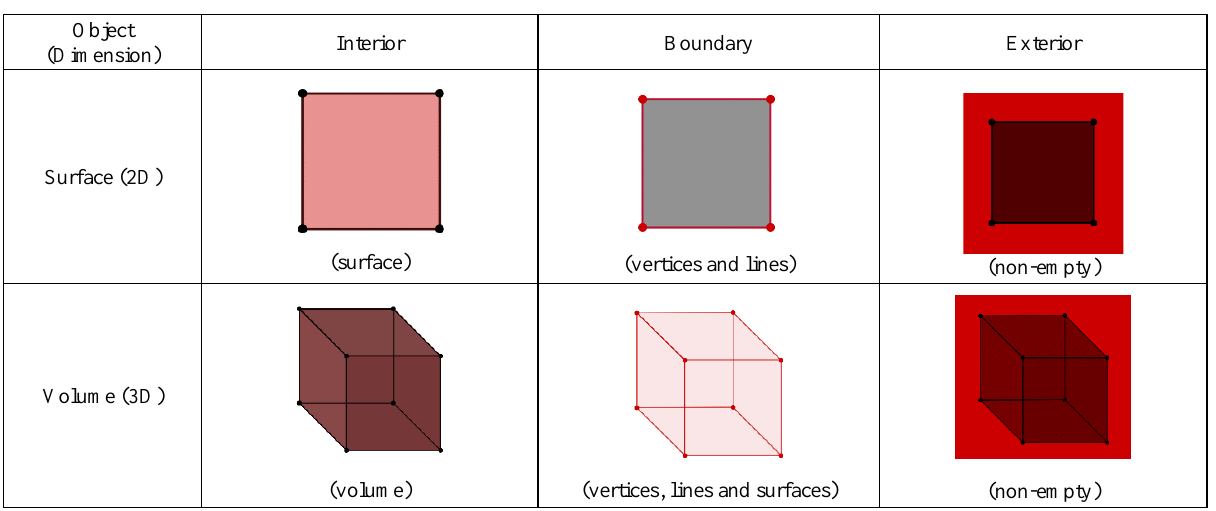
Table 1 . Interior, boundary and exterior of spatial objects in R 3 .